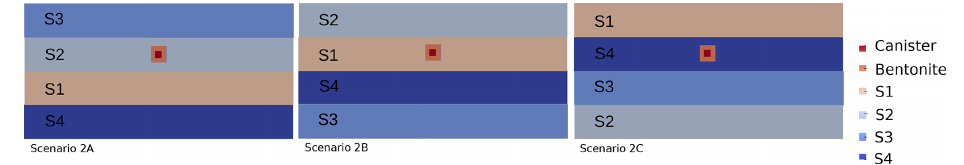
Figure 3. The SF-OPA layer distribution in the conceptual models 2A, 2B and 2C, with the canister emplaced in the S2, S1 and S4 layer, respectively. The combination of canister and bentonite has the fixed position of 0m.